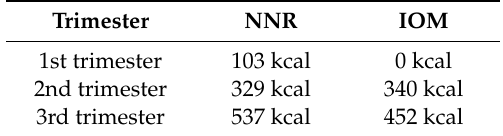
Table 4. Additional daily calorie requirements during